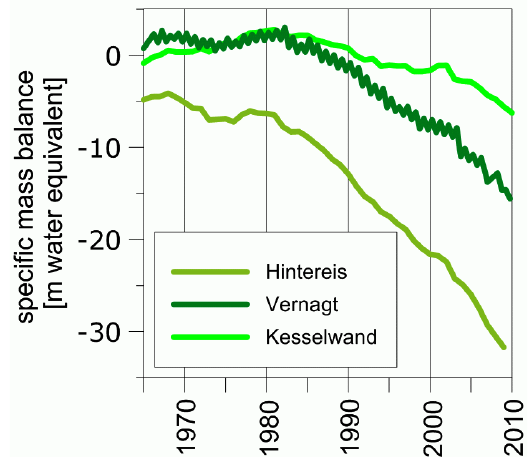
Fig. 3. Cumulative specific mass balance for three glaciers within the ¨ Otztal Alps (Austria) (Kuhn et al., 1999; Fischer and Markl, 2009; WGMS, 2011). Glacier mass loss starts at about